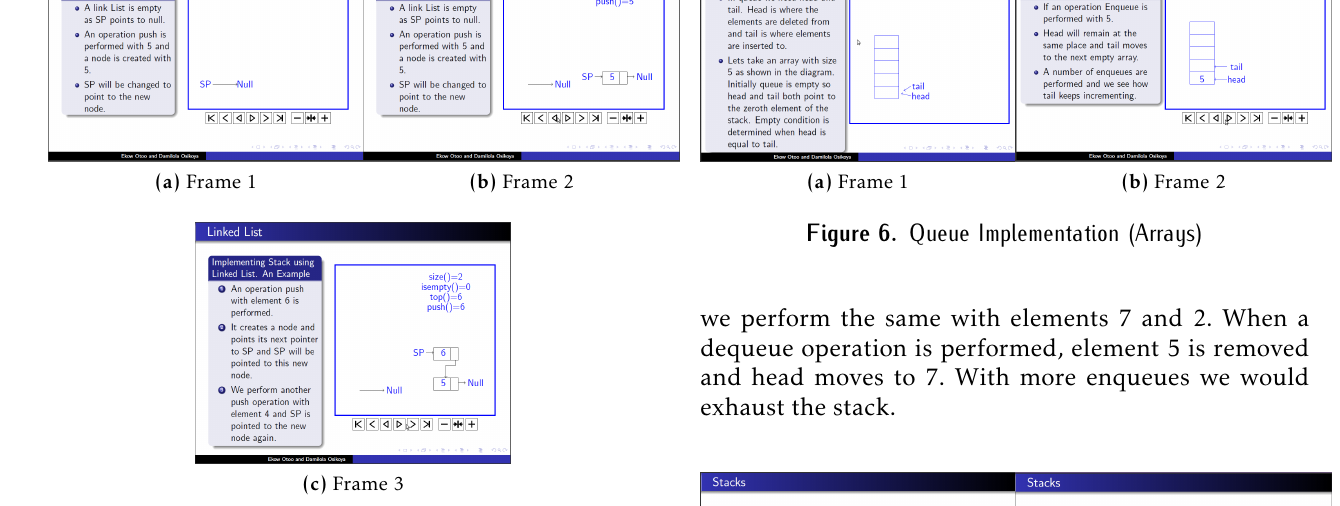
Figure 4. Stack Implementation (Linked List)